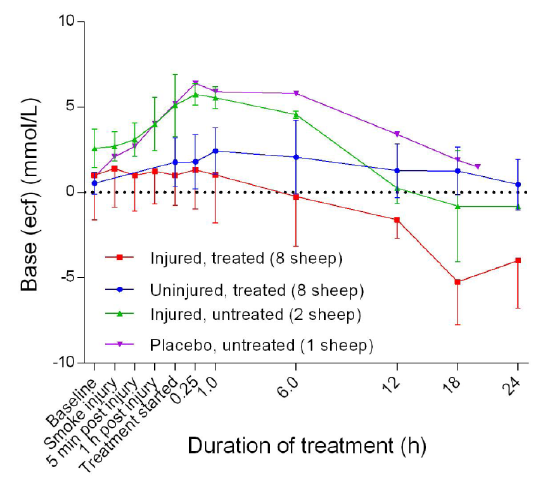
Figure 20. Concentration of base (ecf) in blood (Mean ± SD) for smoke and non-smoke injured sheep receiving extracorporeal life support alongside untreated